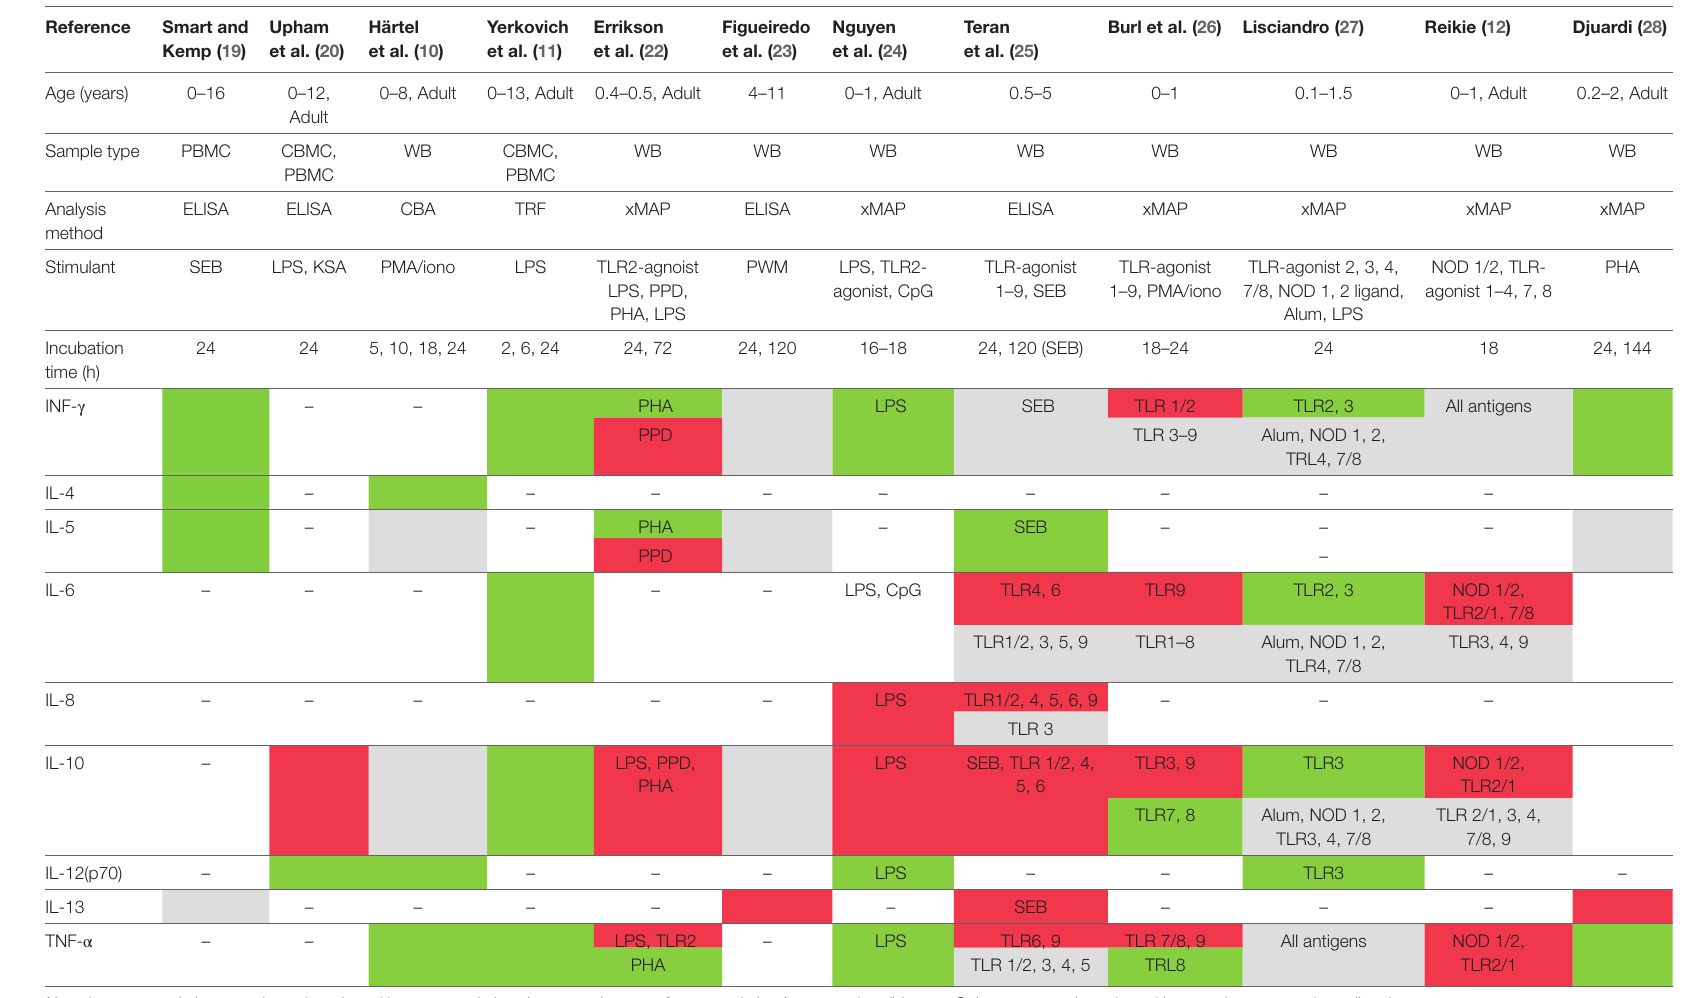
taBLe 5 | Summary of results in studies reporting age association of secreted cytokines using stimulated